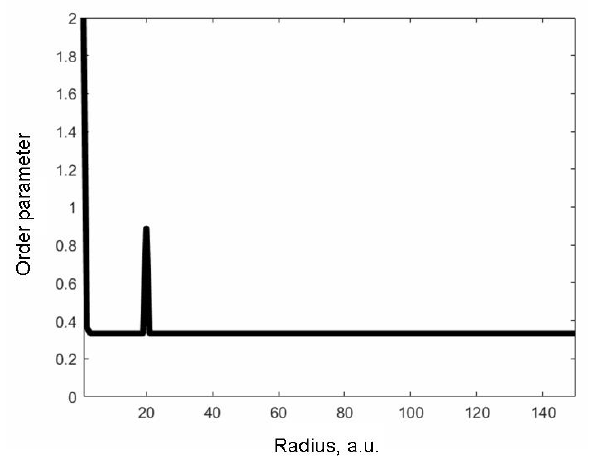
Figure 1. Distribution of order parameter at the initial moment of time in the direction of the defect. The values along the axes are given in relative units.